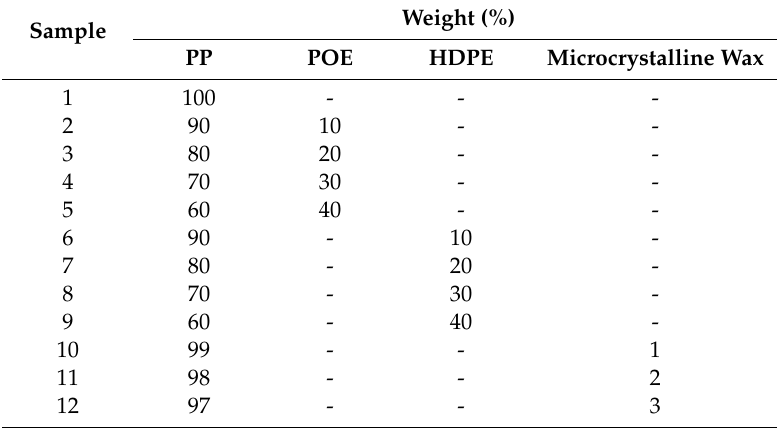
Table 1. Compositions of the polymer